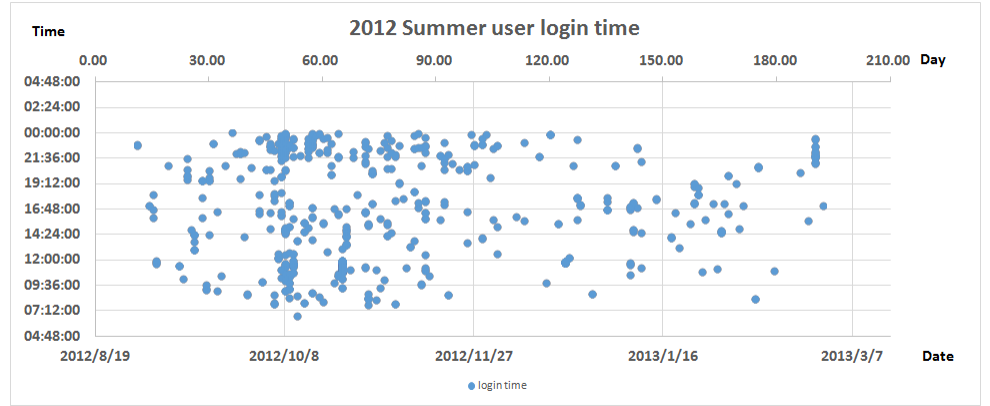
Figure 4 . The login time distribution chart for summer 2012.